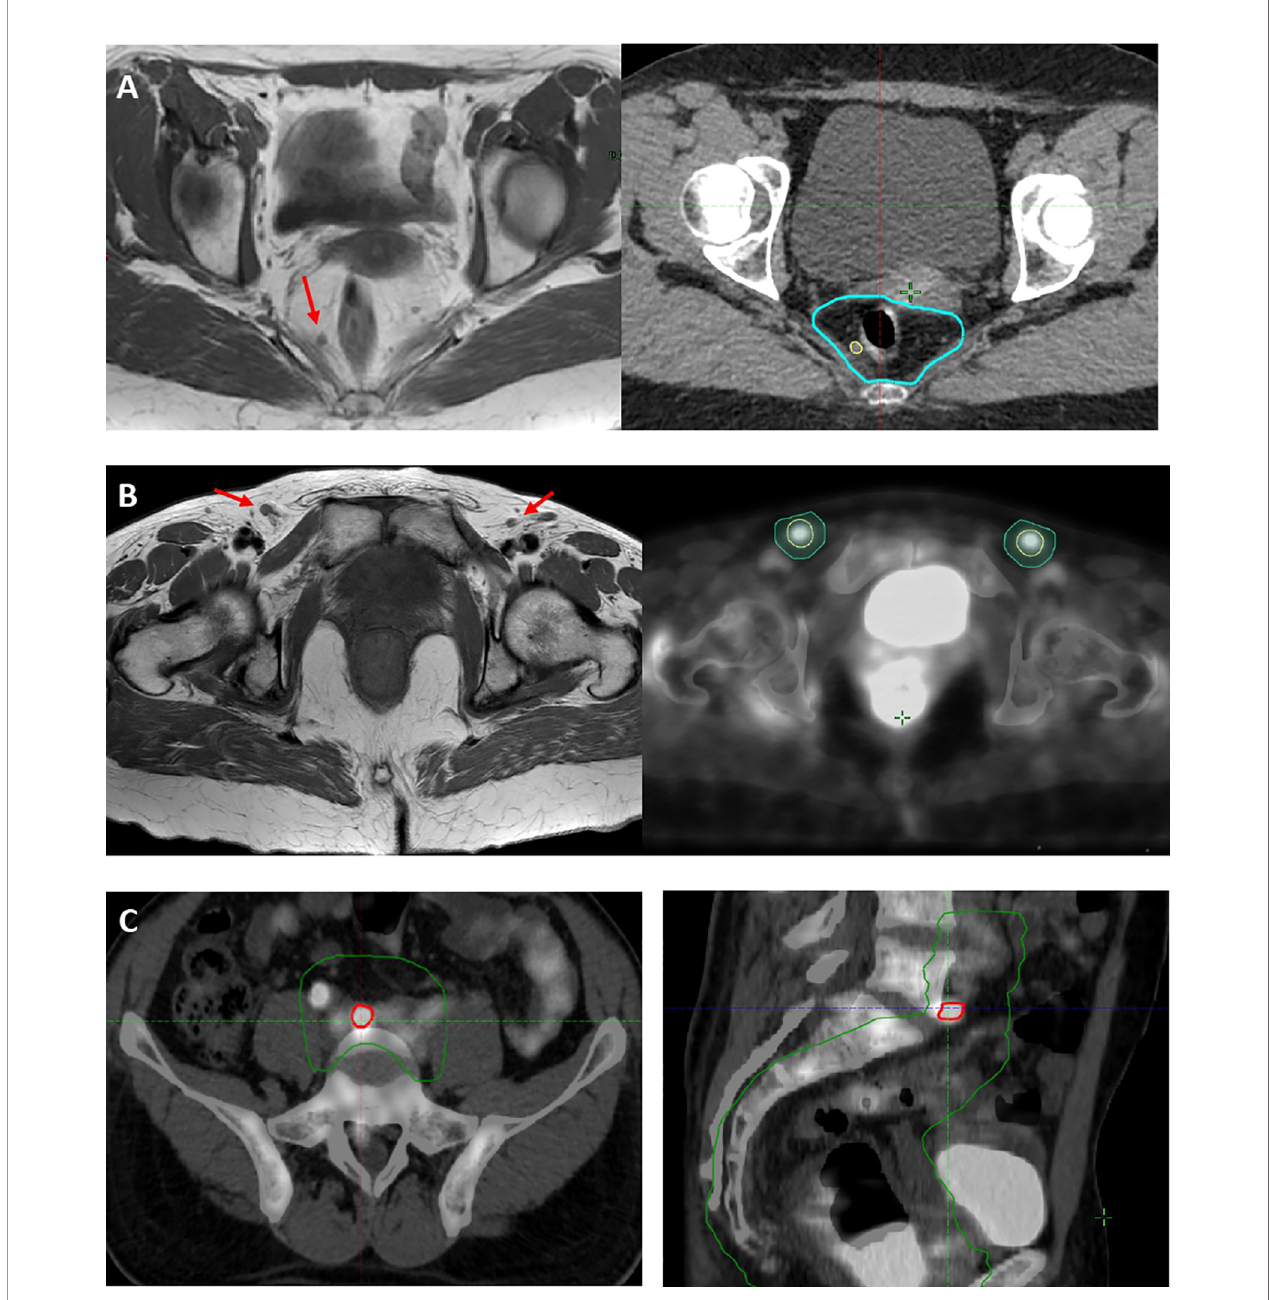
FIGURE 2 | (A) Case of mesorectal PET − /MRI+ LN (red arrow), included as mesorectal GTV N (yellow line) in 54 Gy high-dose volume (light blue line). (B) Case of disease upstage and dose escalation on MRI − (red arrows)/PET+ (yellow line) inguinal LN. (C) Case of disease upstage with a dose escalation on MRI − /PET+ common iliac LN (red line) and inclusion of common iliac LN level to 45 Gy low-dose volume (green